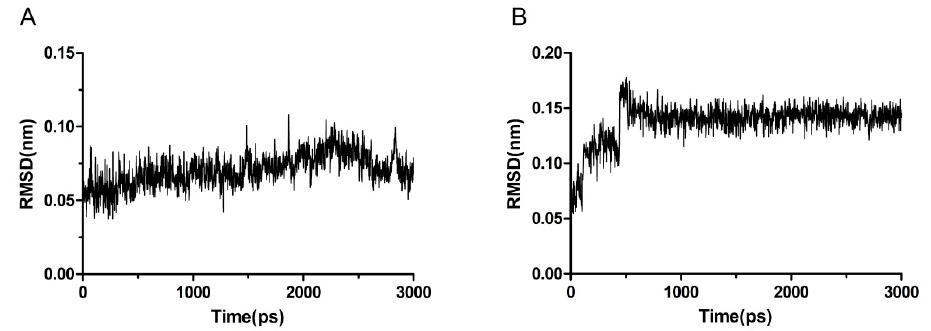
Figure 4. RMSD of compound 13b with c-MET ( A ) and VEGFR-2 ( B ), respectively.